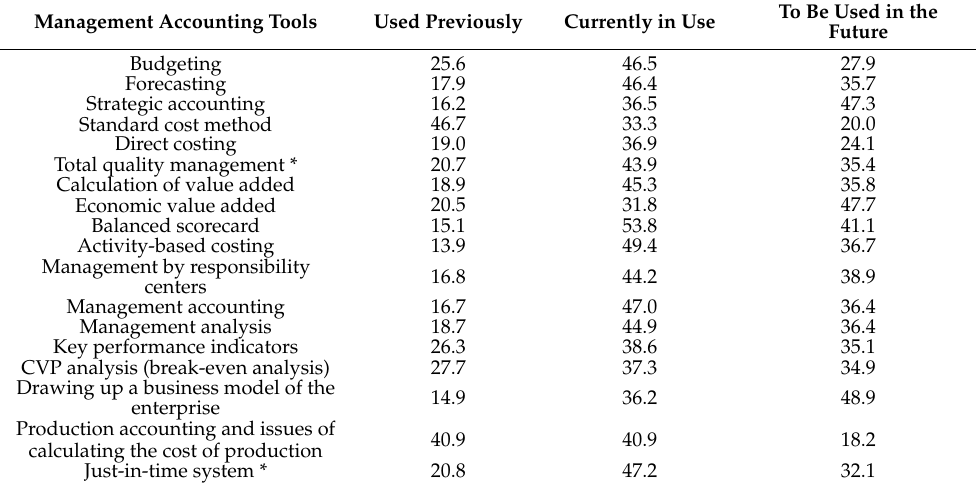
Table 4. Experience of using management accounting tools (according to the results of experts’